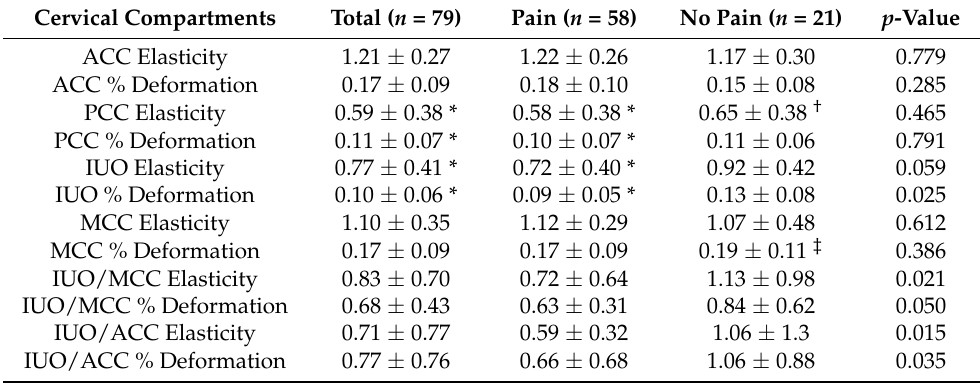
Table 2. Mean ( ± SD) color score elasticity, percent tissue deformation and ratios of different regions of interest of the cervix: Data of women with and without menstrual pain are also reported along with their